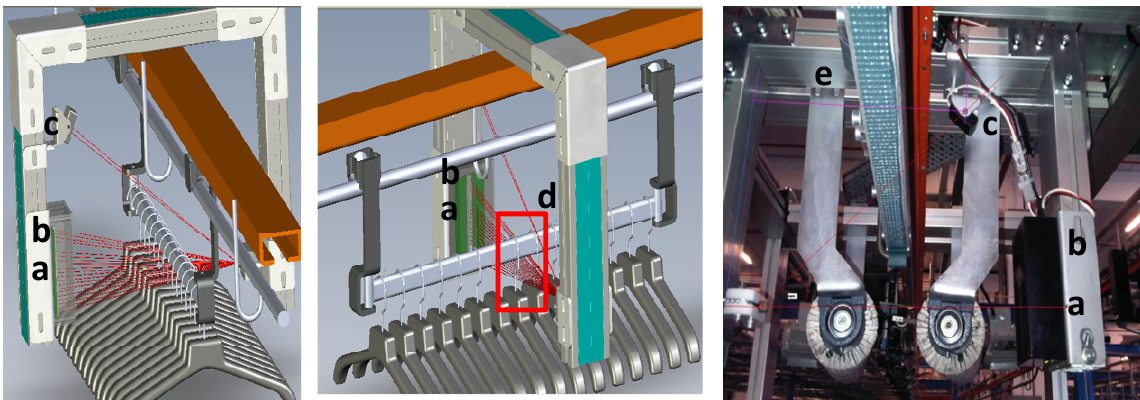
Figure 7. Physical representation of the laser signal exciting the sensors or intersecting with the garments’ hangers. ( a ) hangers’ sensor array, ( b ) Horizontal bar sensors, ( c ) Vertical bar sensors, ( d ) target intersecting zone between the laser beam and hanger hooks, ( e ) Real system